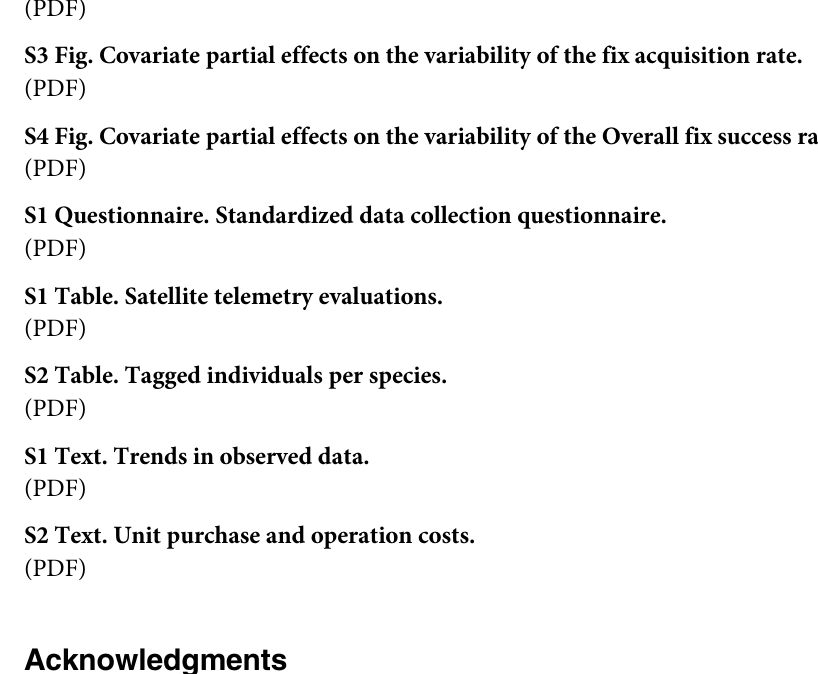
S2 Fig. Distribution of response variables and covariates. S3 Fig. Covariate partial effects on the variability of the fix acquisition rate. S4 Fig. Covariate partial effects on the variability of the Overall fix success rate.